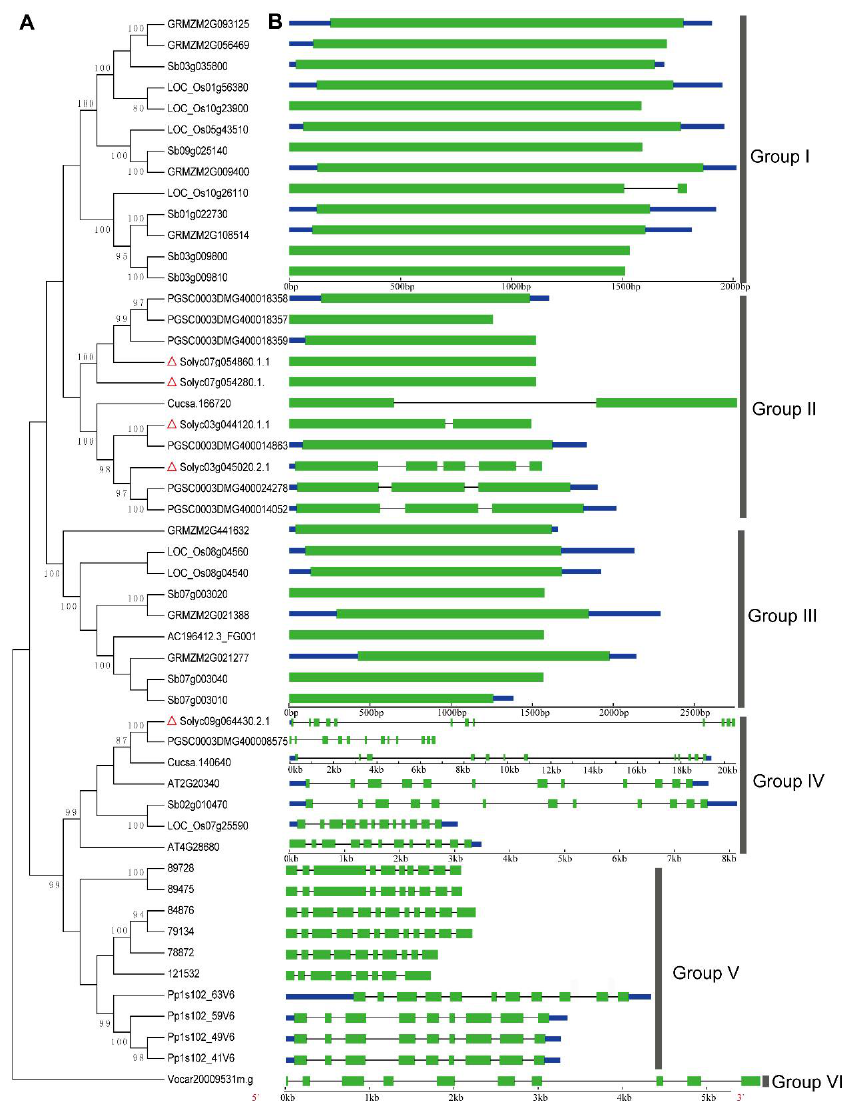
Figure 2. Phylogenetic relationship and exon/-intron structure of the SlTrpDC genes. ( A ) The neighbor-joining phylogenetic tree was inferred from the amino acid sequences alignment of the TrpDC genes. ( B ) The exon-intron structures are the filled green boxes (exons) and lines (introns). The blue box showed untranslated region. Red triangles showed TrpDC genes from Solanum lycopersicum . Bootstrapping (1000 replicates) was used to evaluate the degree of support for a